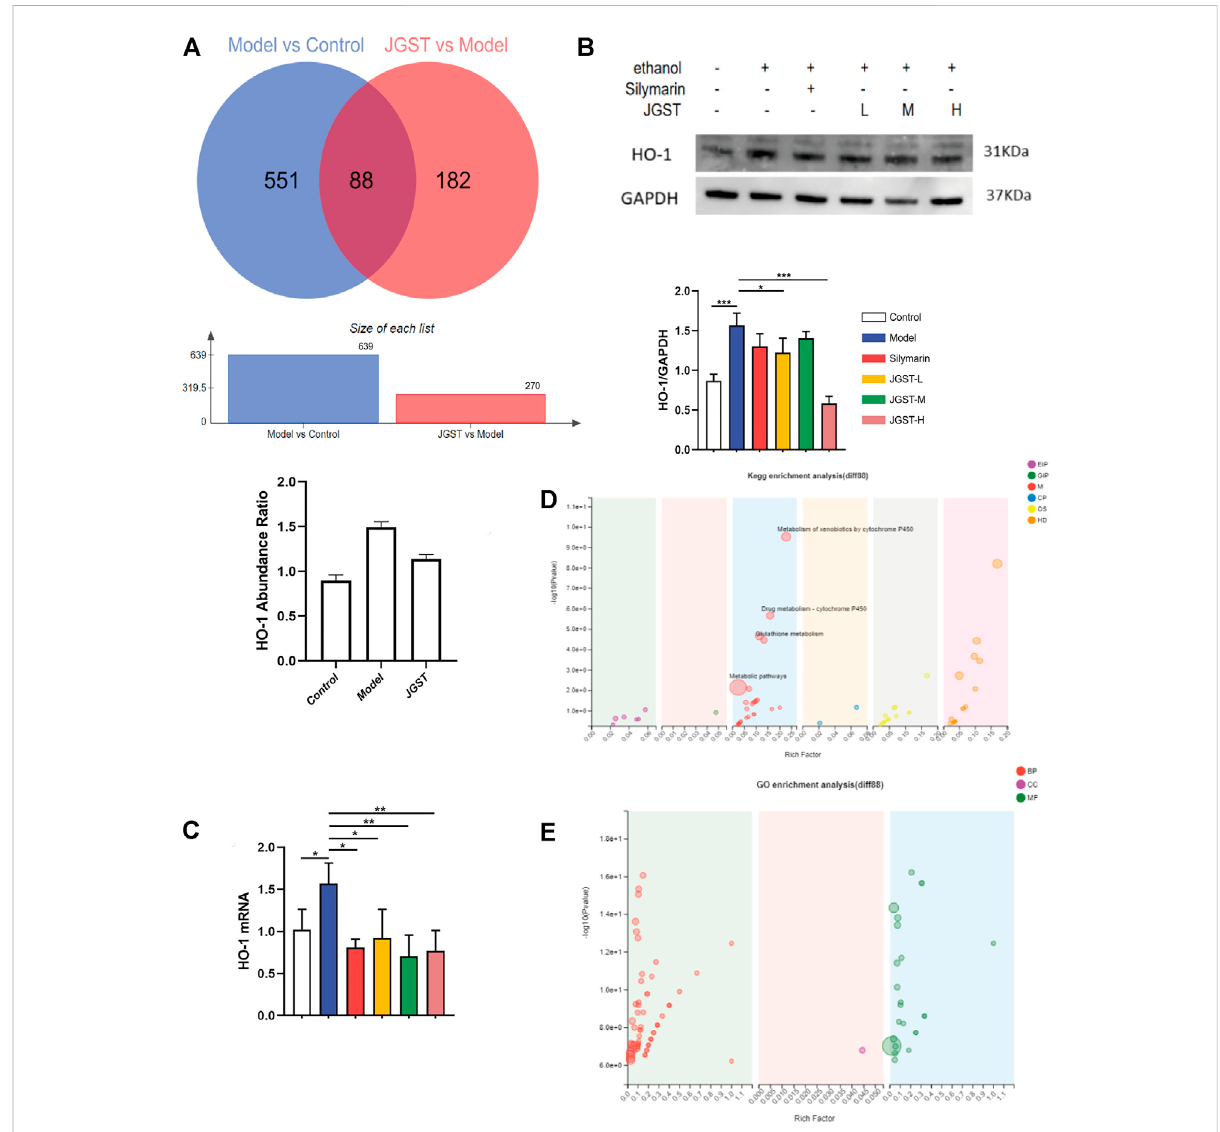
FIGURE 5 Differential proteins and overlapping protein enrichment analysis in the liver of ALD mice. (A) differential protein analysis in proteomics. (B) The protein expression of HO-1 in liver tissue. (C) GO enrichment analysis. (D) KEGG enrichment analysis. (E) GO enrichment analysis. Data were presented as Meant ± SEM, * p < 0.05, ** p < 0.01, *** p < 0.001, n =